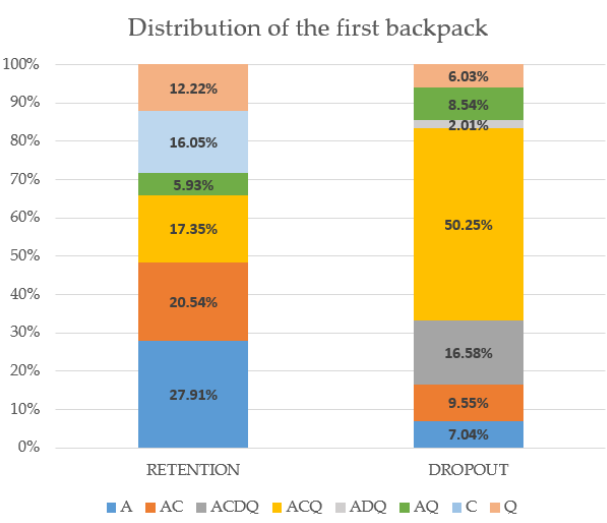
Figure 10d Appl. Sci. 2021 , 11 , x FOR PEER REVIEW